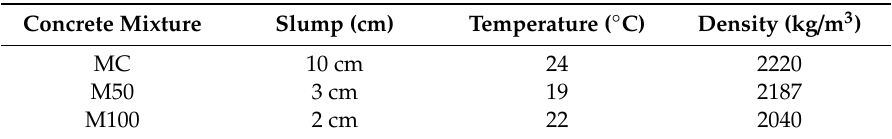
Table 3. Physical properties of concrete mixtures.